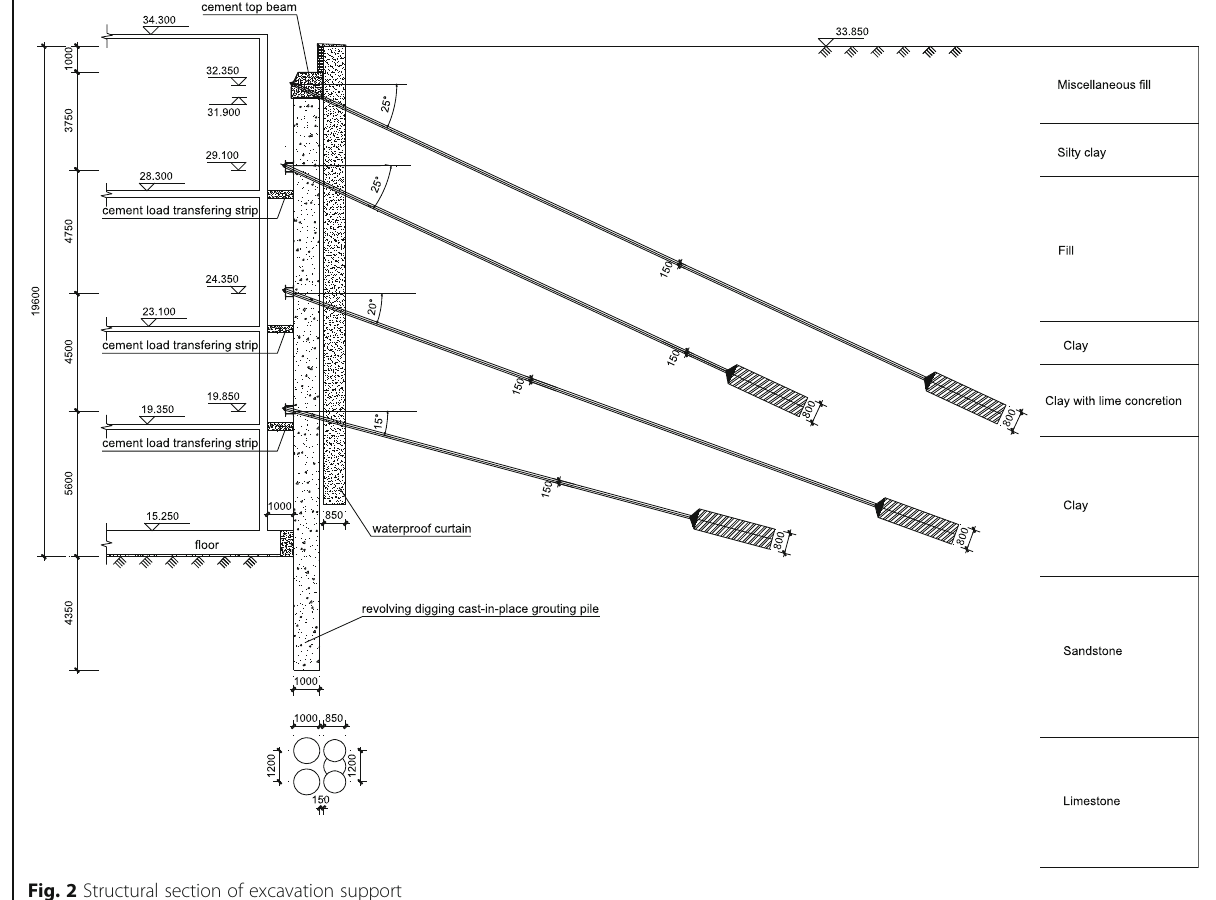
Orifice relative elevation (m)